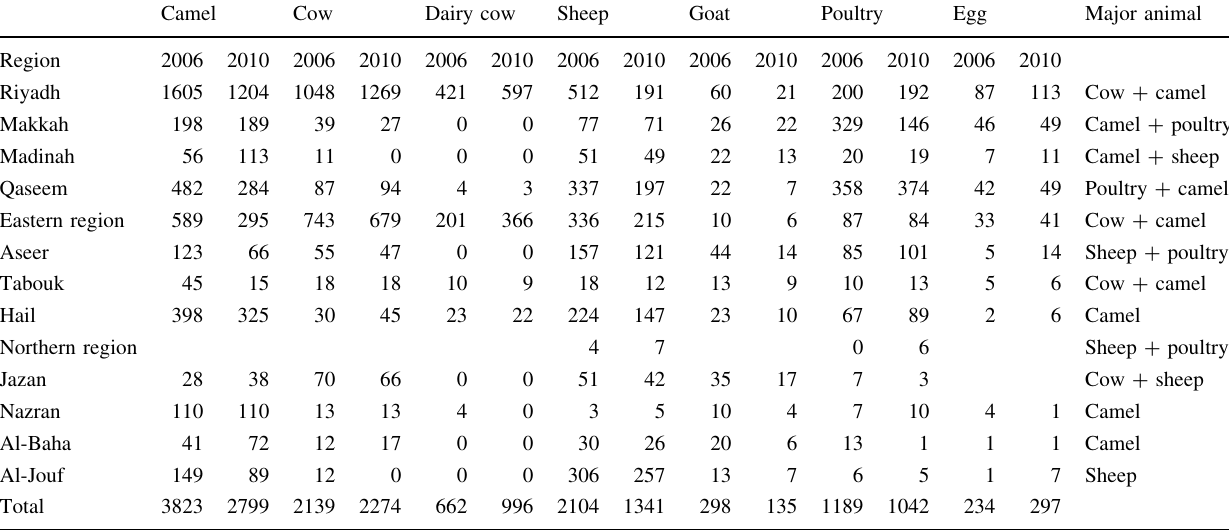
Table 7 Trend of virtual water content (million m 3 ) for farm livestock production in Saudi Arabia Camel Cow Dairy cow Sheep Goat Poultry Egg